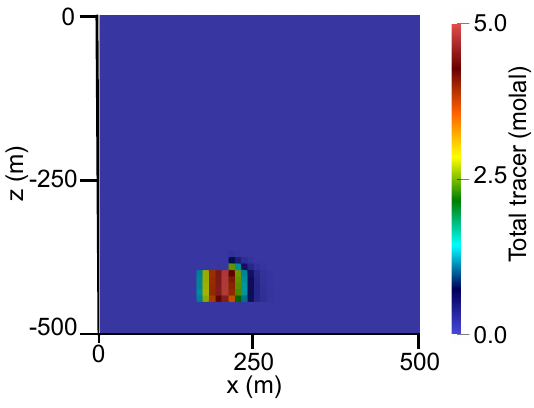
Figure 4. PFLOTRAN Simulation: Spatial distribution of tracer concentrations after one